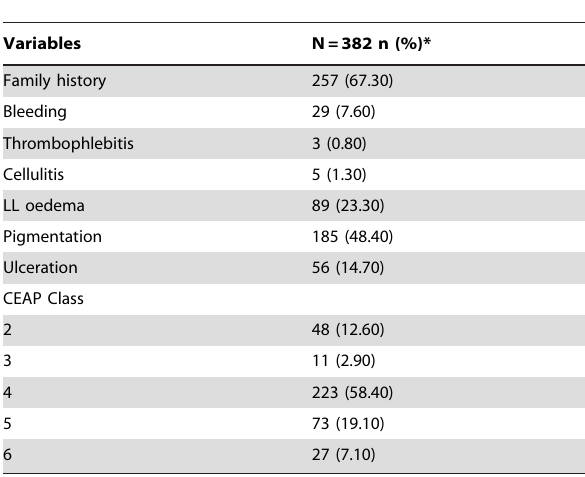
Table 2. Clinical features in patients with